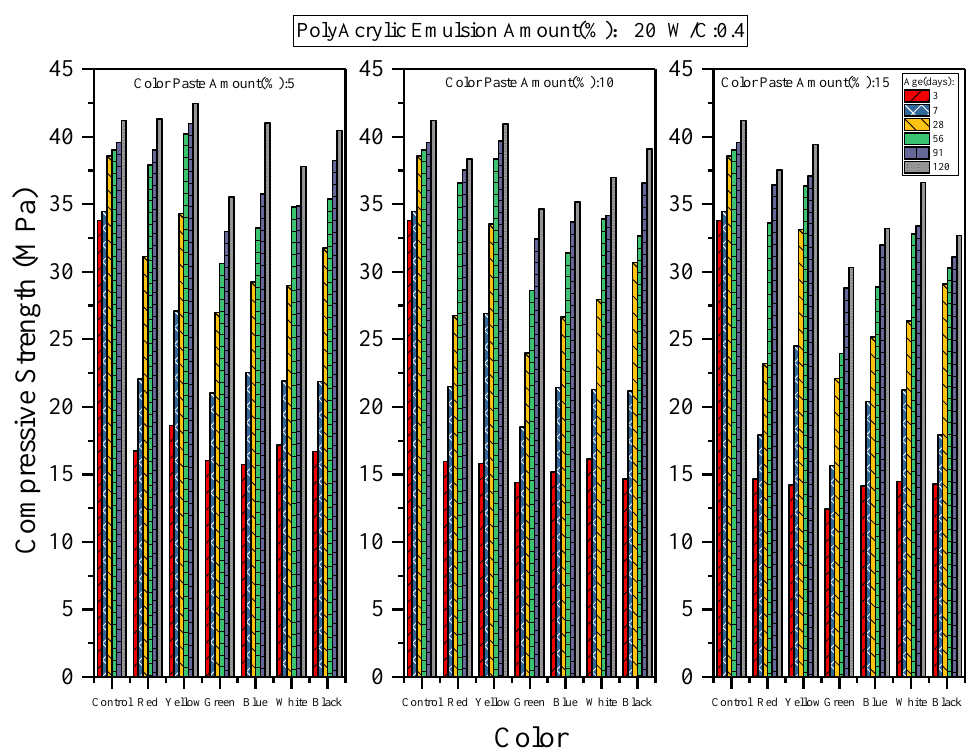
Figure 5. W/C 0.4 Compressive strength of mortar with different proportions of inorganic color paste.